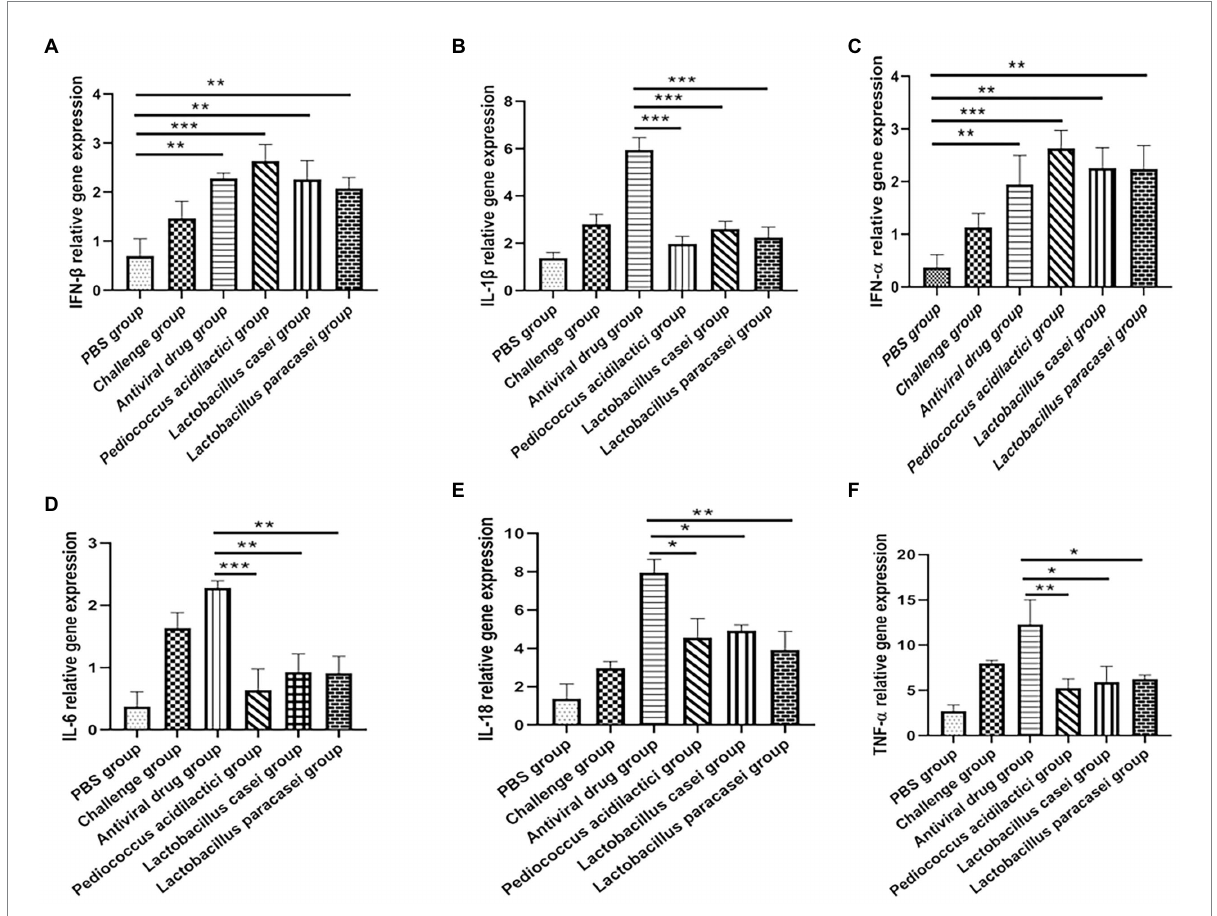
FIGURE 3 Lactobacillus and porcine intestinal epithelial cell cultures were used to quantify the cytokines produced by cells. (A) , IFN- β relative gene expression. (B) , IFN- α relative gene expression. (C) , IL-1 β relative gene expression. (D) , IL-6 relative gene expression. (E) , IL-18 relative gene expression. (F) , TNF- α relative gene